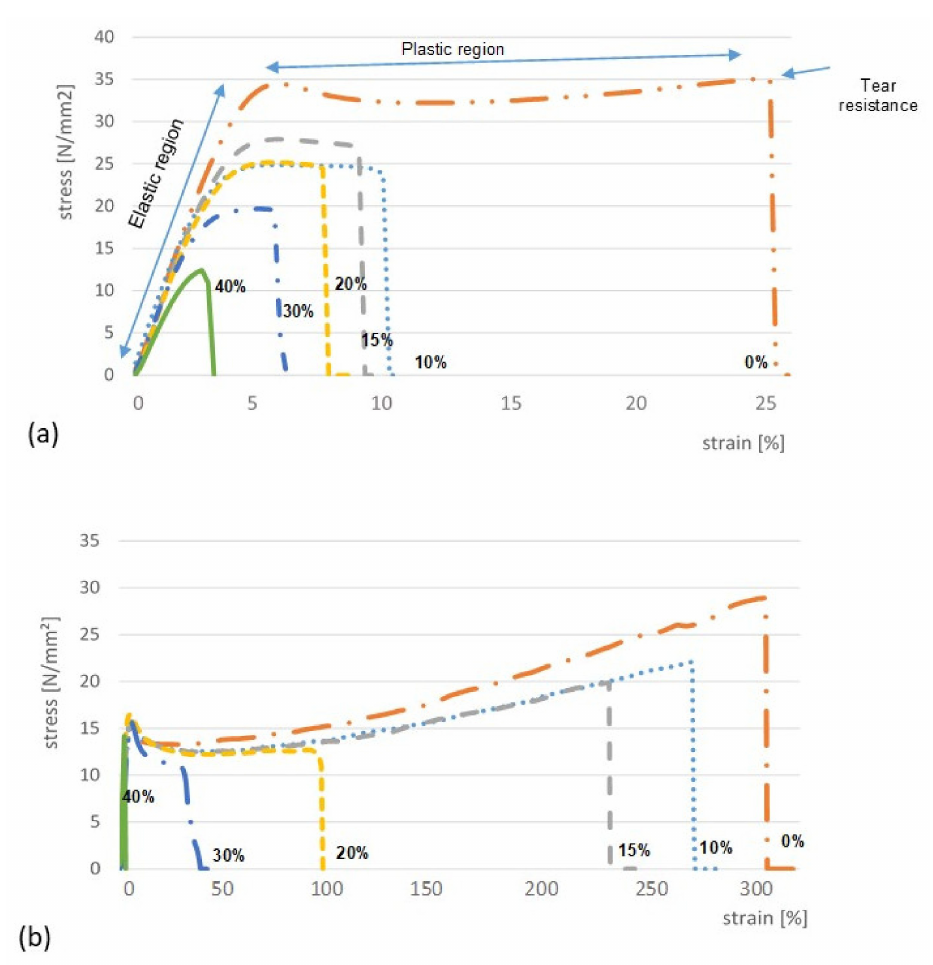
Figure 5. The influence of di ff erent loadings of solid particles (LO 0%–40%) on stress–strain diagrams in relation to the polymer type in ODFs: ( a ) HPMC 606 and ( b ) AP /